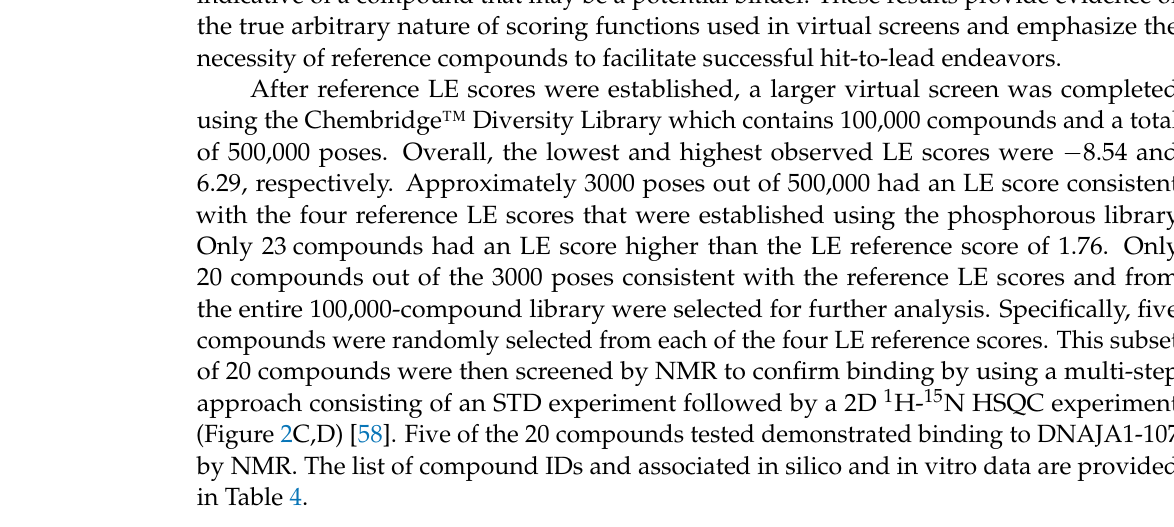
Table 4. Hit2Lead compounds that bind